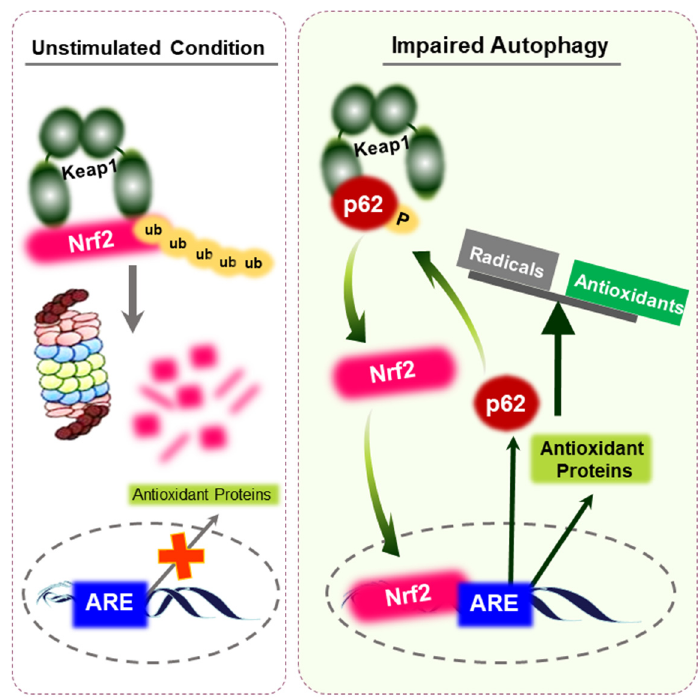
Figure 3. Activation of Nrf2 through p62 accumulation. Under unstimulated conditions, Nrf2 is constantly ubiquitinated by Keap1 and is rapidly degraded by the proteasomes. Upon impaired autophagy, defective accumulation of p62 results in the sequestration of Keap1. This leads to the release of Nrf2 protein and consequent potentiation of antioxidant capacity, provoking reductive stress. p62 is a target gene for Nrf2, implying that a positive feedback loop exists within the p62-Keap1-Nrf2 axis. Accumulated reductive stress might maintain the survival and resistance of cancer cells.